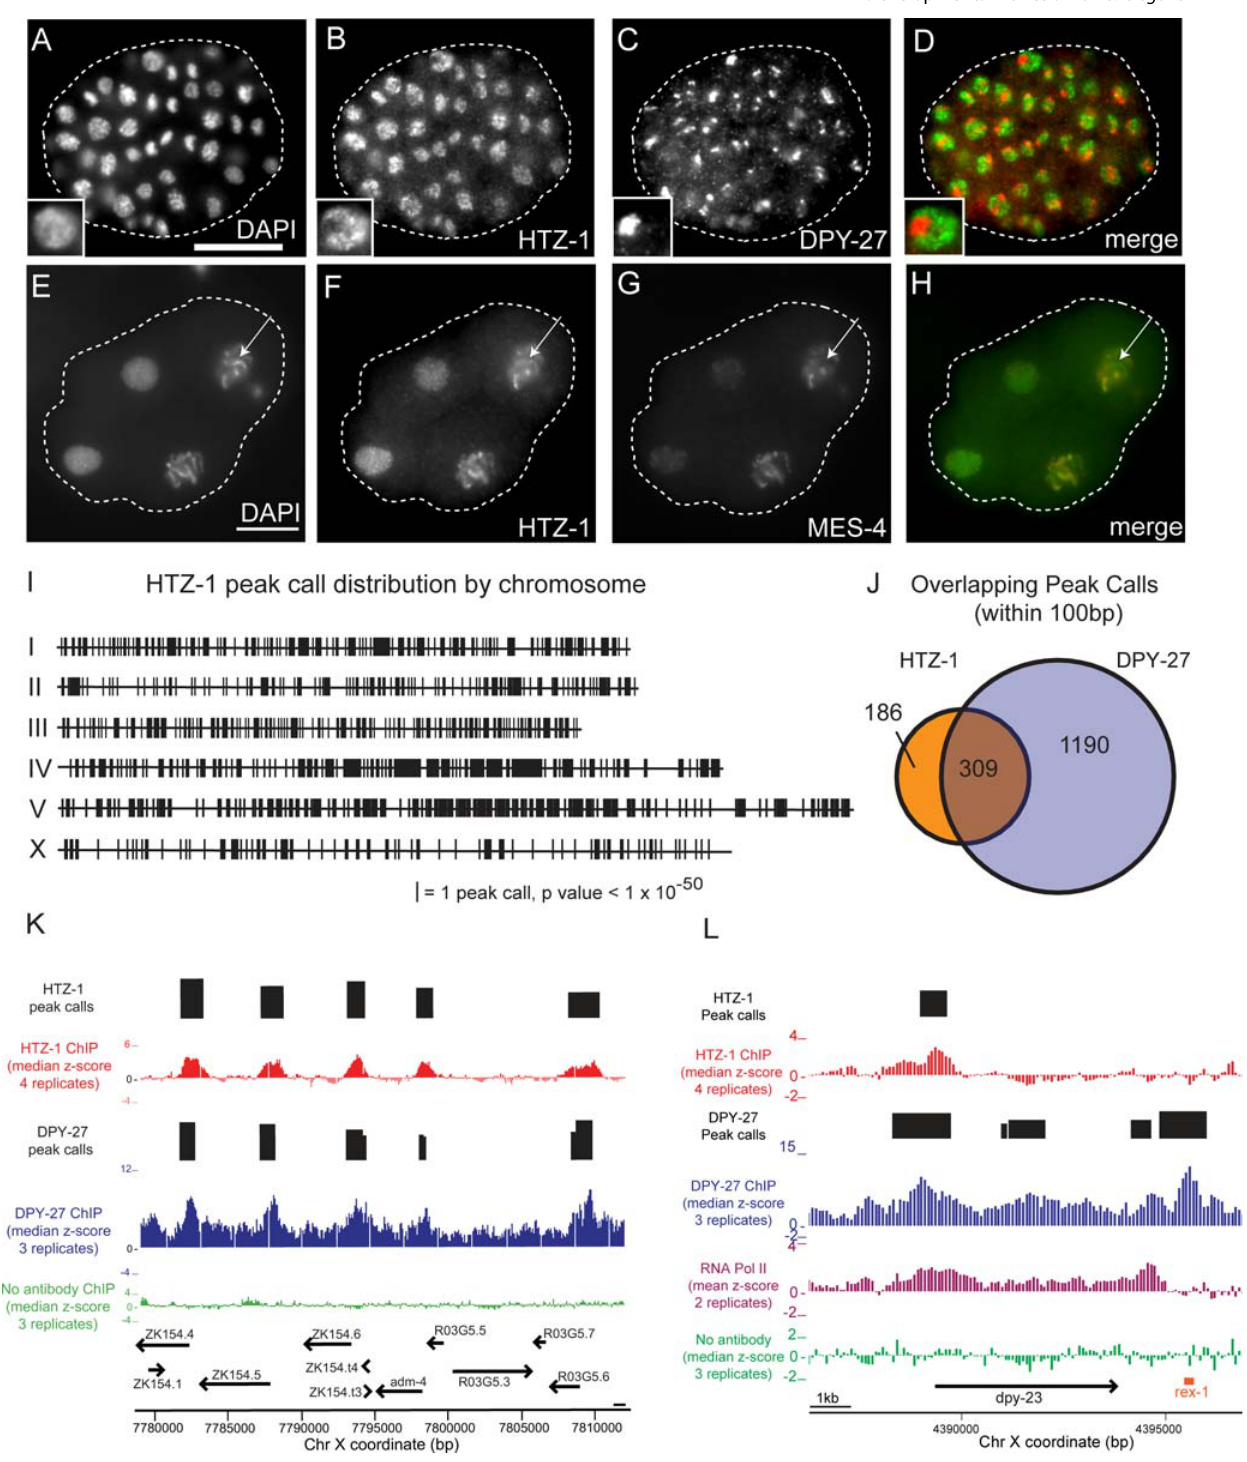
Figure 7. There are fewer sites of HTZ-1 incorporation on the X chromosome, but those that occur generally co-localize with the Dosage Compensation Complex. Immunofluorescence staining of an N2 embryo with (A) DAPI, (B) anti-HTZ-1, and (C) anti-DPY-27. (D) Merged image, HTZ-1 (green) and DPY-27 (red). One cell is enlarged 2 6 to highlight the distinction between DPY-27 and HTZ-1 staining (lower left). Immunofluorescence staining of a 4-cell N2 embryo with (E) DAPI, (F) anti-HTZ-1, and (G) anti-MES-4. (H) Merge of HTZ-1 (red) and MES-4 (green). Arrows point to the X chromosome. White scale bars indicate 10 m m. While some HTZ-1 incorporation on X is evident, note that the X is the brightest chromosome in the field by DAPI, but that HTZ-1 staining is brighter for other chromosomes, particularly the autosome at the bottom of the nucleus, than X. (I) Sites of HTZ-1 binding plotted along the chromosomes. Each line denotes one peak found with ChIPOTle using a Bonferroni corrected p- value of 1 6 10 2 50 . (J) Locations of HTZ-1 incorporation were compared with DPY-27 peak distribution [51]. The Venn diagram displays the coincidence (peak maximum probes occurring within 100 bp) between the 495 HTZ-1 peaks and 1499 DPY-27 peaks on X. (K) A browser view of a 50- kb region of the X chromosome. Median z-scores (ChIP/Input) derived from four HTZ-1 ChIPs (red), three DPY-27 ChIPs (blue) [51] and three ‘‘no antibody’’ ChIPs (green) are plotted. HTZ-1 and DPY-27 binding peaks (black bars) and gene annotations (arrows) are indicated. (L) A browser view of the dpy-23 locus; same as (K) with the addition of RNA Polymerase II ChIP (purple). The rex-1 DCC recruitment element is shown in orange. doi:10.1371/journal.pgen.1000187.g007 PLoS Genetics |